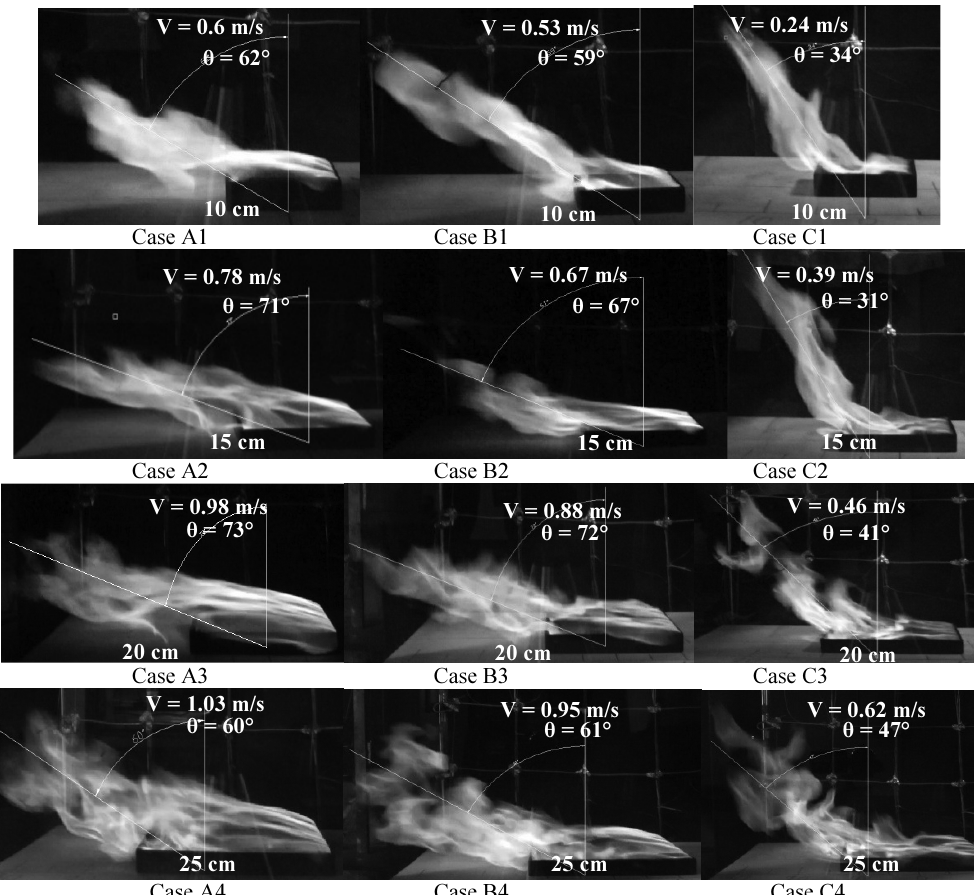
Fig. 6. Flame tilt angle θ and air speed V through Door 3 in different cases (Case A1-A4: Top vent open, Door 3 Size: 2 0.12 m ; Case B1-B4: Top vent open, Door 3 Size: 0.24 m